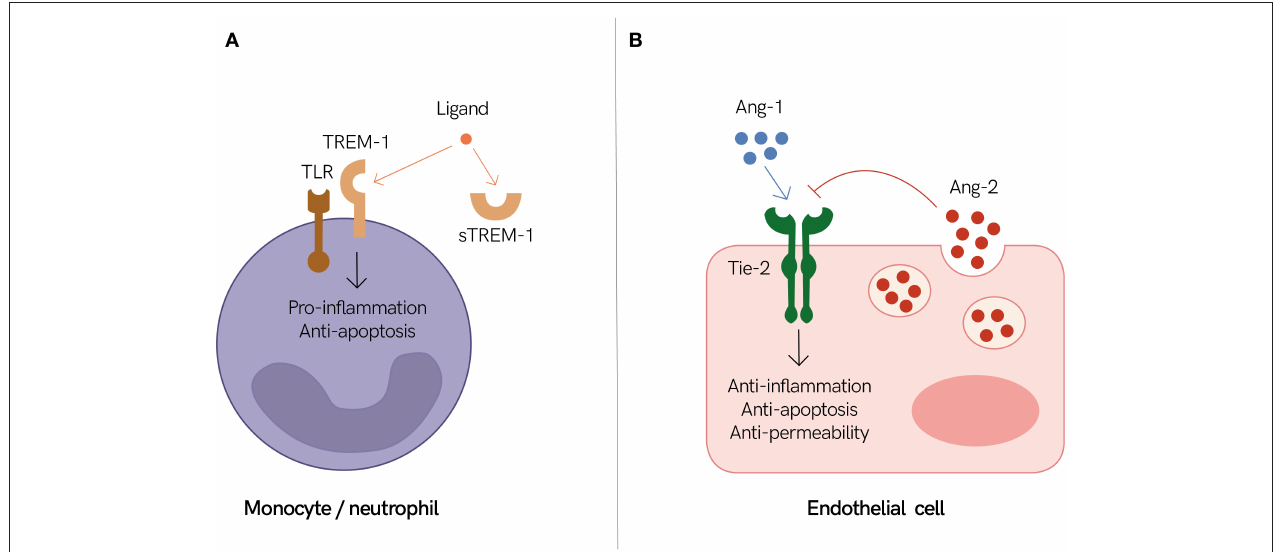
FIGURE 1 | Endothelial and immune mediators as prognostic biomarkers of severe infections. (A) Triggering receptor expressed on myeloid cells 1 (TREM-1) together with Toll-like receptors (TLR) promote inflammation during an active infection. It is speculated that high levels of circulating soluble TREM-1 (sTREM-1) inhibit TREM-1 signaling by sequestrating its ligand. Therefore, individuals with high levels of circulating sTREM-1 may have a dysregulated immune response. (B) The endothelium shifts between states of quiescence (i.e., stable endothelium) and activation (i.e., permeable endothelium) to adapt and accommodate pathogen sequestration and elimination, as well as vascular remodeling and healing. The angiopoietin and tyrosine-protein kinase receptor (Ang/Tie) axis plays an important role in regulating these events. Angiopoietin-1 (Ang-1) activates Tie-2, which promotes endothelium stabilization, while angiopoietin-2 (Ang-2) inhibits these events, thereby promoting endothelium activation. Individuals with high levels of circulating Ang-2 may suffer from a dysregulated host response to infection resulting in excessive endothelium activation and vascular leak. (A,B) Both sTREM-1 and Ang-2 are associated with poor outcomes in different infectious diseases and thus are good candidates to help identify individuals with impending life-threatening